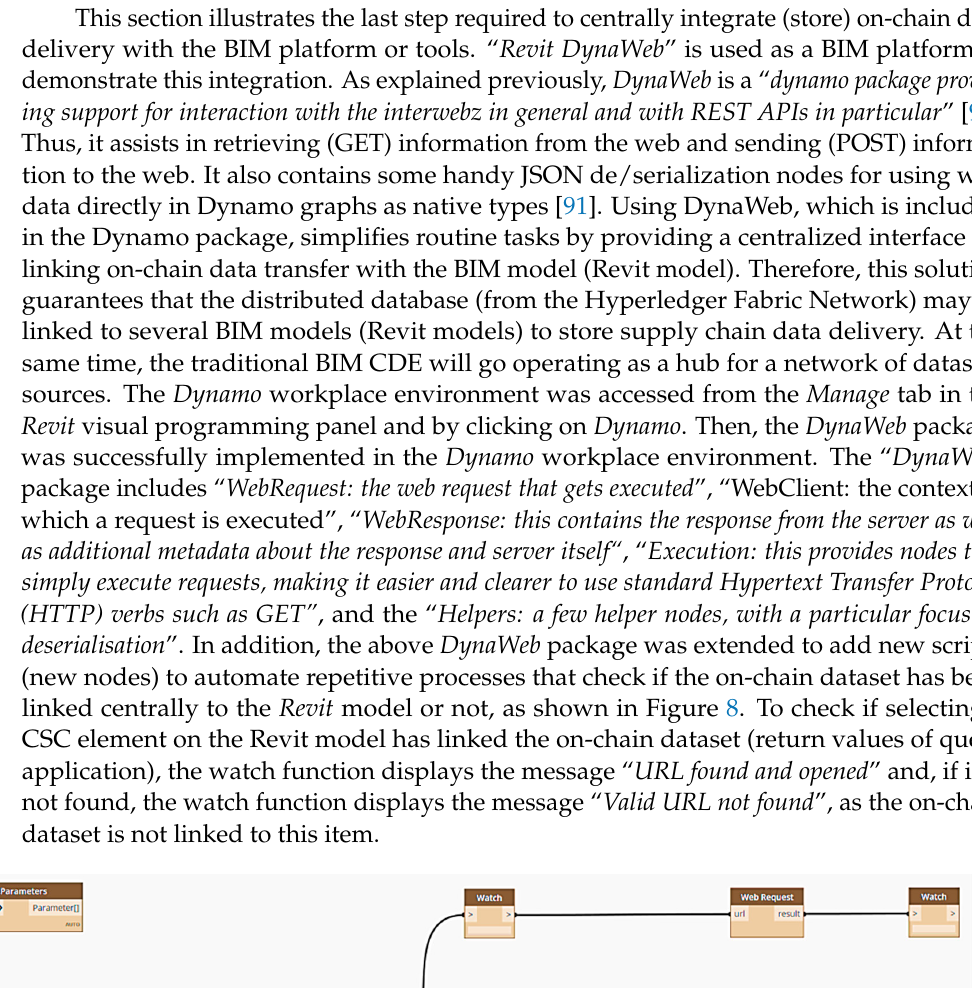
Figure 9. Successful linking of the on-chain dataset (the return values of the query application) to Revit (the BIM platform) and displaying (accessed) its transaction values. Considering this, the system prototype successfully demonstrated the solution for or integrated blockchain and BIM using Hyperledger Fabric v2.3 and Revit DynaWeb v2021 .